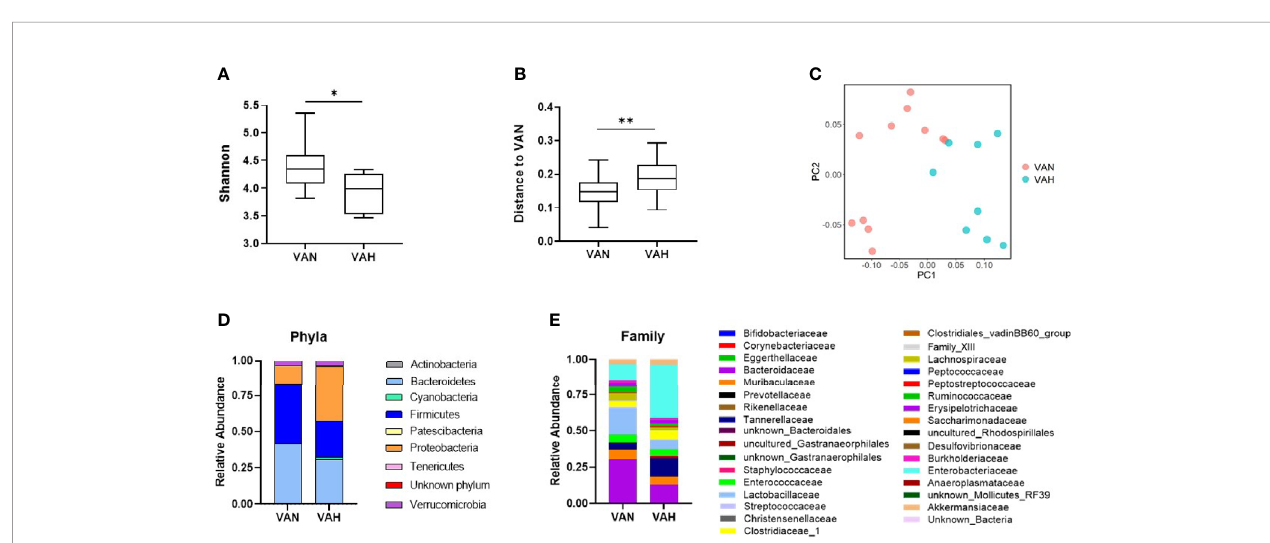
FIGURE 5 | Dietary vitamin A supplementation modulates recipient gut microbiota after allogeneic BMT. (A) Lethally irradiated VAN and VAH mice were transplanted with BM (7 x 10 6 ) plus 0.3 – 0.4 x 10 6 puri fi ed T cells from B6 mice. On Day 7 after BMT, fecal samples were collected and 16S rRNA sequencing was performed. (A) Shannon index of gut microbiota as a measure of alpha diversity; (B) Weighted UniFrac analysis of microbiota b -diversity. (n = 9 – 11 per group). Data are shown as Mean ± SEM and are cumulative results from 3 independent experiments. (C) Principle coordinate analysis (PCoA) using Weighted UniFrac distance of gut microbiota sourced from VAN and VAH mice reveal beta diversity differences; (D) Relative abundance of microbial community at the phylum level. (E) Relative abundance of microbial community at the family level. Statistics: * P ≤ .05, ** P ≤ .01.